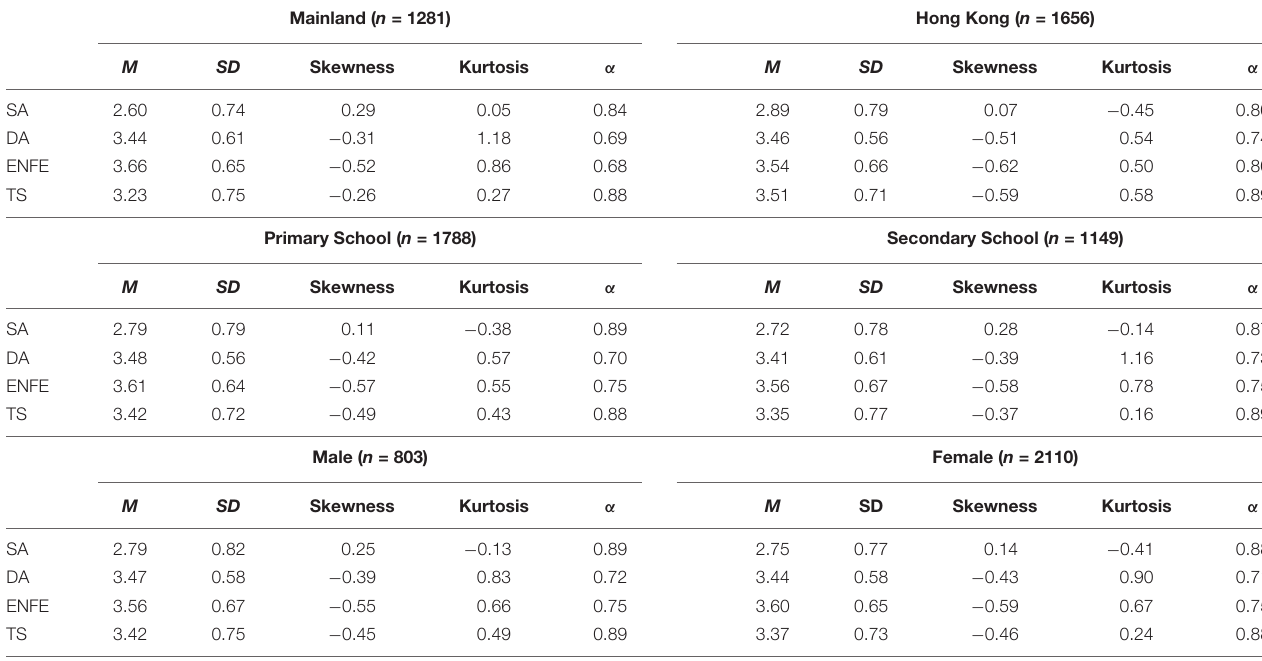
TABLE 1 | Descriptive statistics and reliabilities for